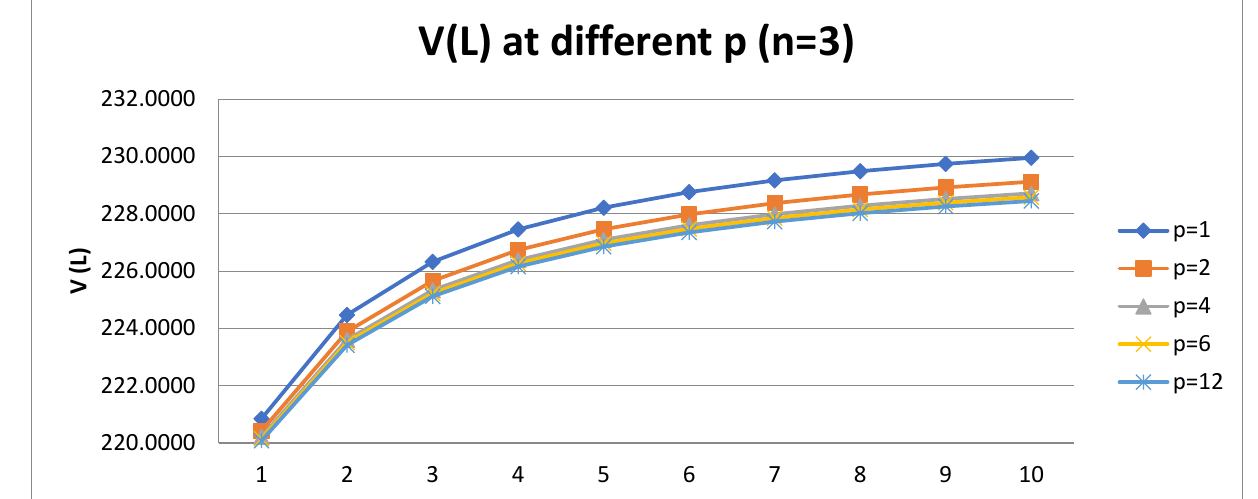
Figure 2. The dependence of the company value (V) on the leverage level (L) of a three-year-old company for advance profit tax payments with frequencies of p = 1, 2, 4, 6 and 12.